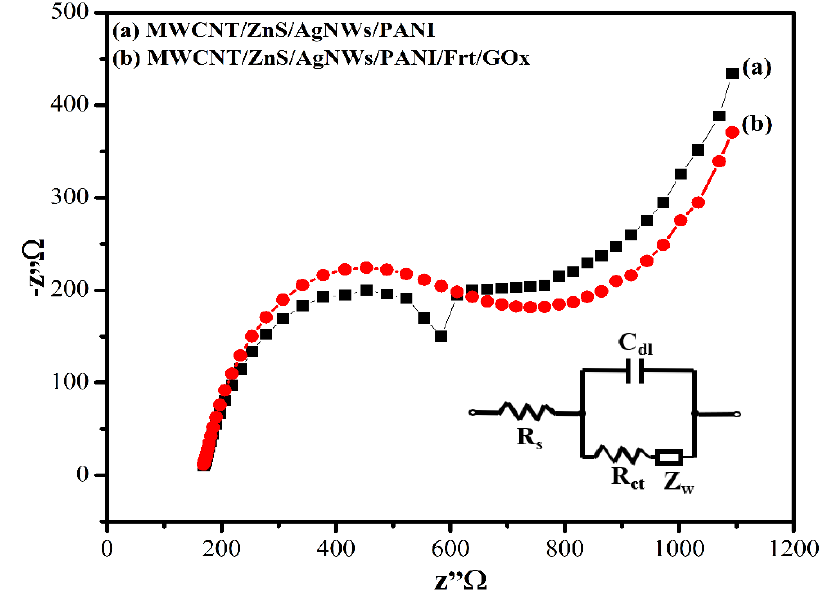
Figure 11. Nyquist plot of ( a ) GCE/(MWCNT/ZnS/AgNWs/PANI ( b ) GCE/(MWCNT/ZnS/AgNWs/ PANI/Frt/GOx.